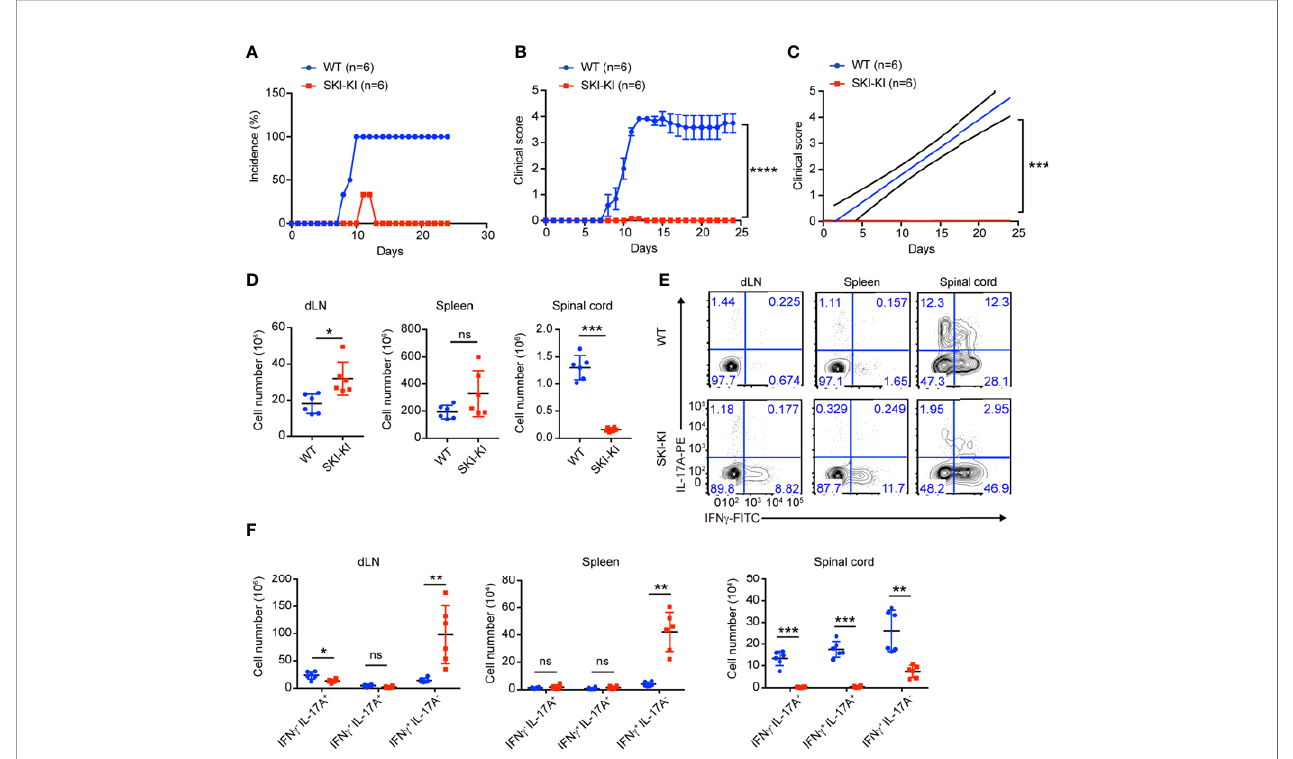
FIGURE 2 | Reduced disease severity and decreased Th17 cells in SKI-KI mice during EAE. (A – C) The disease incidence (A) and the recorded clinical scores (B) and the linear-regression analysis (C) of WT and SKI-KI mice at different time points after EAE elicitation. N = 6 mice each group, representative of two independent experiments; mean ± s.e.m., ***p < 0.001, ****p < 0.0001, by two-way multiple-range ANOVA. (D) Total cell number of spleens, draining lymph nodes (dLN) and in fi ltrating cells in spinal cords of WT and SKI-KI mice at day 25 after EAE elicitation. Data were pooled of six mice per group from two independent experiments; means ± s.d.; ns, not signi fi cant, * P < 0.05, **p < 0.01, by two-sided Student ’ s t -test. (E) The population of IFN g -, IL-17A-producing CD4 + T cells in draining lymph nodes (dLN, left), spleens (middle) and spinal cords (right) analyzed by fl ow cytometry at day 25 of EAE. The results were representative for six mice from two independent experiments. (F) The cell number of IFN g -, IL-17A-producing CD4 + T cells in draining lymph nodes (dLN, left), spleens (middle) and spinal cords (right) at day 25 of EAE. Data were pooled of 6 mice from two independent experiments; mean ± s.d., ns, not signi fi cant p > 0.05, **p < 0.01, ***p < 0.001, by two-sided Student ’ s t